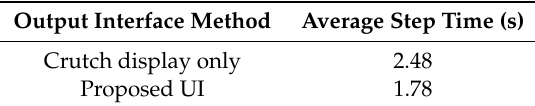
Figure 11. Walking speed result for each trial. The step length of each step was set as 30 cm, and the step time was controlled by the pilot’s intention. Table 2. Step time of difference